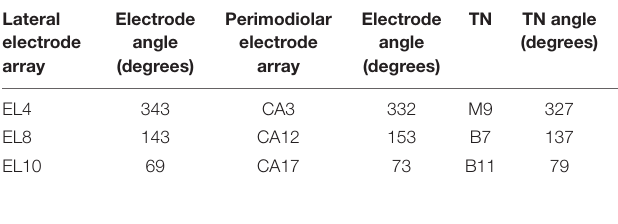
TABLE 1 | Angles of the investigated electrodes and the corresponding target neurons (TN) measured from the round window with respect to modiolus axis; compare Figure 1 .